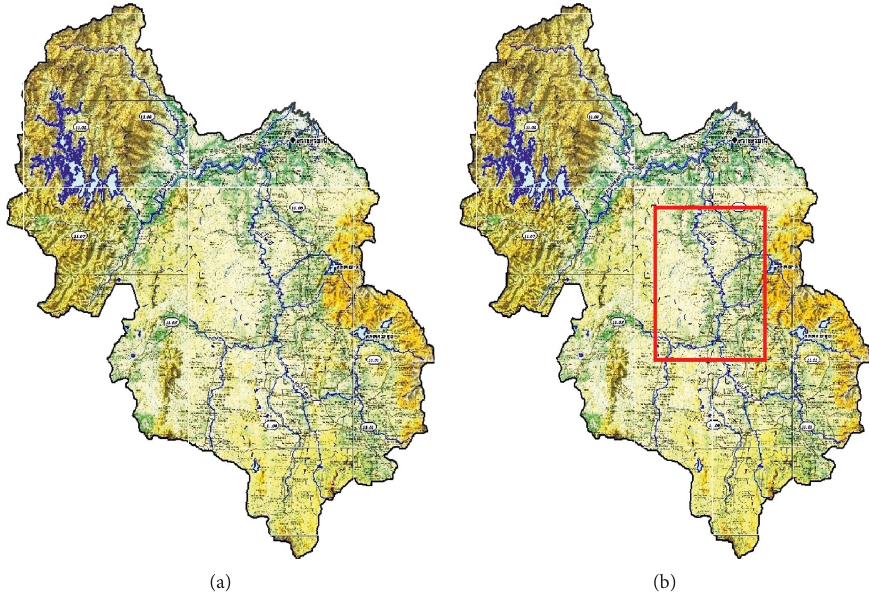
F IGURE 17: Tapi basin in the south of Thailand